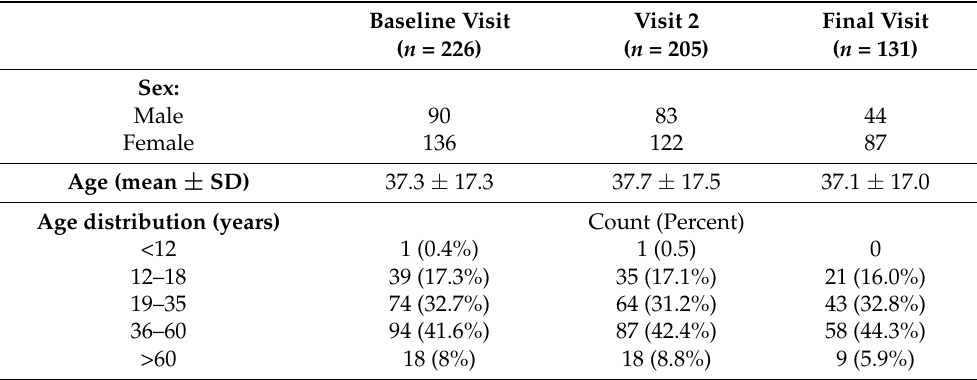
Figure 1. Consort flow chart. Visit 1: baseline visit; Visit 2: intermediate visit; Visit 3: final visit. Table 1. Demographic data of the study population.